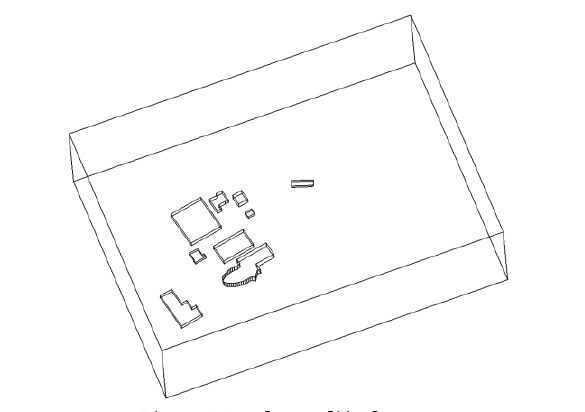
Table 1. Preliminary meshing algorithm characterization with